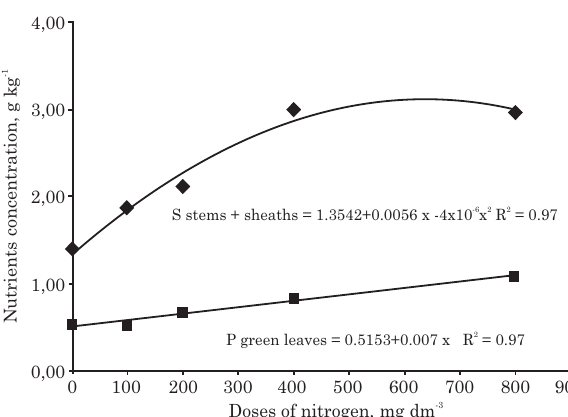
Figure 8. Influence of nitrogen fertilization on P concentration in green leaves and S concentration in stems + sheaths of Brachiaria decumbens .